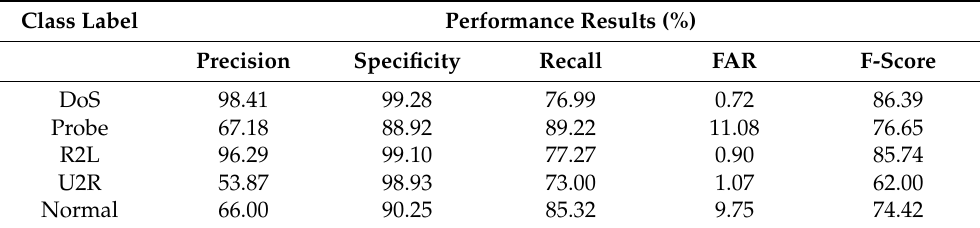
Table 15. Standard LSTM performance results on NSL-KDDTest − 21 using 21